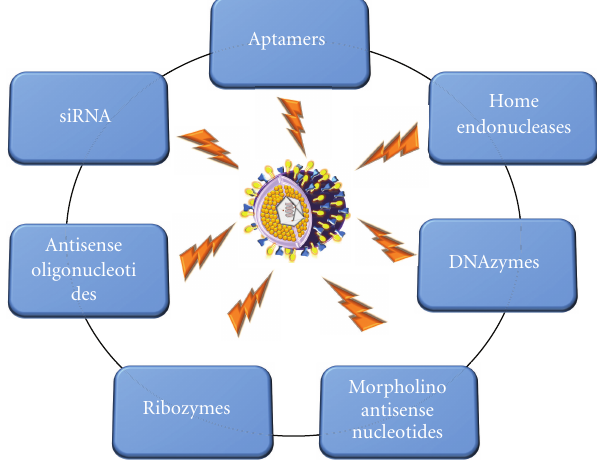
Figure 2: Successful targeting of HSV-1 genome by gene therapy to date. Abbreviations: DNAzymes: deoxyribozymes; siRNA: small interfering RNA; HSV-1: herpes simplex virus serotype